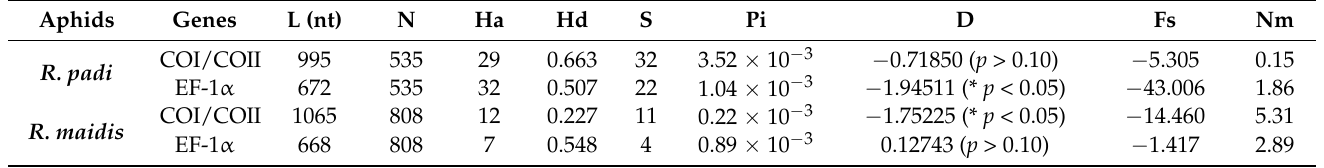
Table 1. Analysis of haplotypes and Tajima’s D neutrality test of 32 R. padi and 38 R. maidis